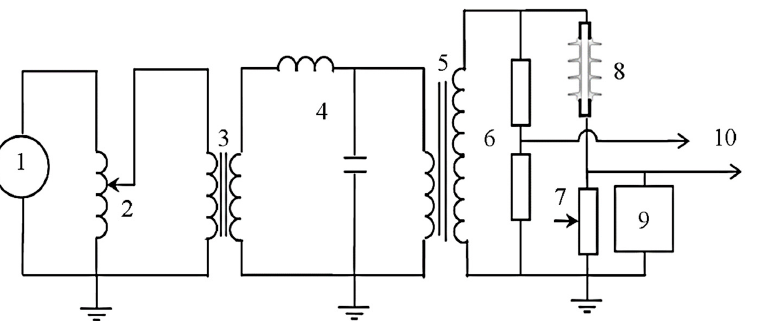
Figure 2. Circuit diagram of the experimental setup. 1: 240 V AC, 2: Voltage regulator, 3: 1:1- Isolation transformer, 4: Low pass filter, 5: Step-up transformer, 6: Voltage divider, 7: Variable resistor, 8: Test Insulator, 9: Protection box, 10: Digital oscilloscope